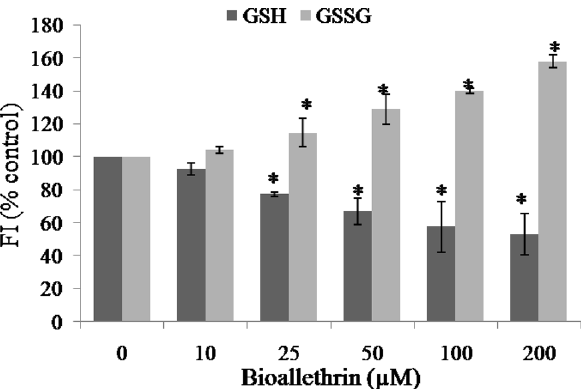
Figure 2. Effect of bioallethrin on reduced and oxidized glutathione levels. GSH and GSSG levels were determined fluorometrically in cell lysates and are shown as percent control, taking fluorescence of control sample as 100%. Lymphocytes were incubated with bioallethrin for 2 h at 37 °C. Results are ± standard deviation of six different samples. *Significantly different from control at P < 0.05. GSH reduced glutathione; GSSG oxidized glutathione; FI fluorescence intensity (arbitrary units).